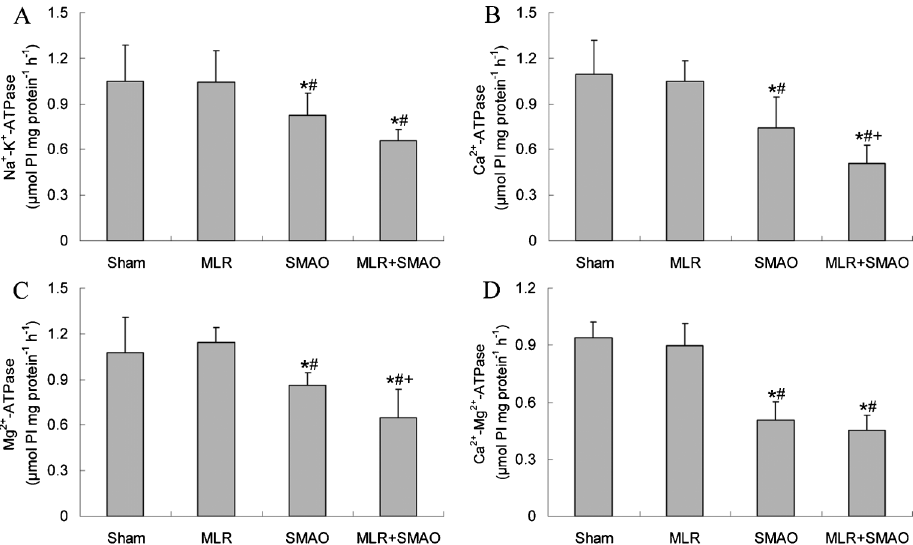
Figure 4. Effect of mesenteric lymph reperfusion (MLR) on the adenosine triphosphatase (ATPase) activity in splenic homogenate of rats with superior mesenteric artery occlusion (SMAO) shock. Data are reported as means±SD, n=6. A , Na + -K + -ATPase activity.